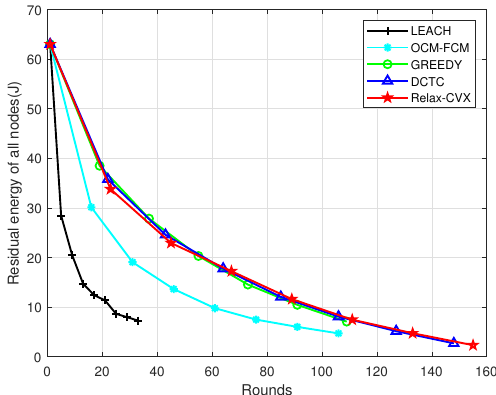
Figure 4. Residual energy of all nodes versus the number of rounds.